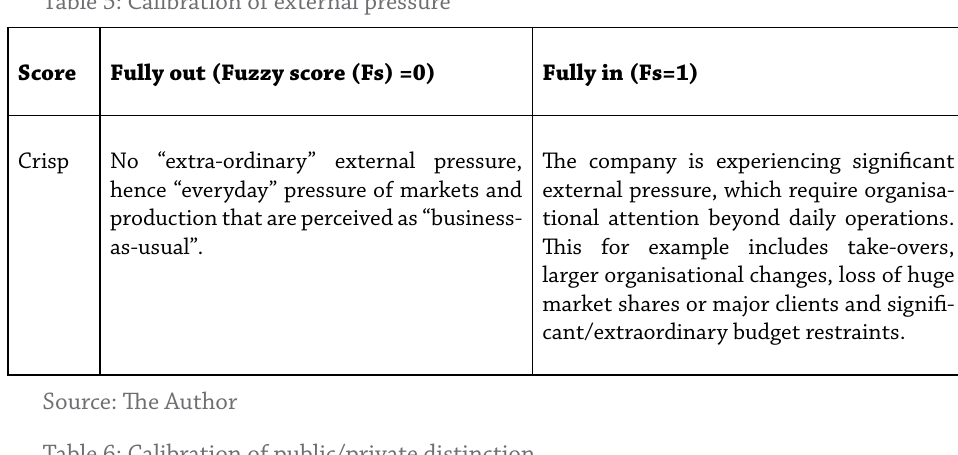
Table 6: Calibration of public/private distinction Score Fully out (Fuzzy score (Fs) =0) Fully in (Fs=1)